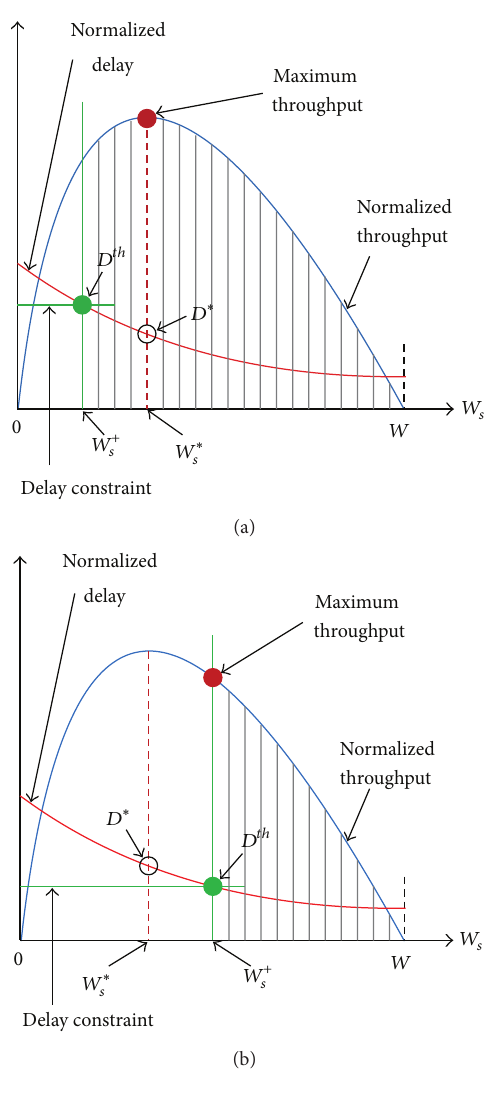
Figure 3: Illustration of the curves: normalized throughput R and normalized delay D